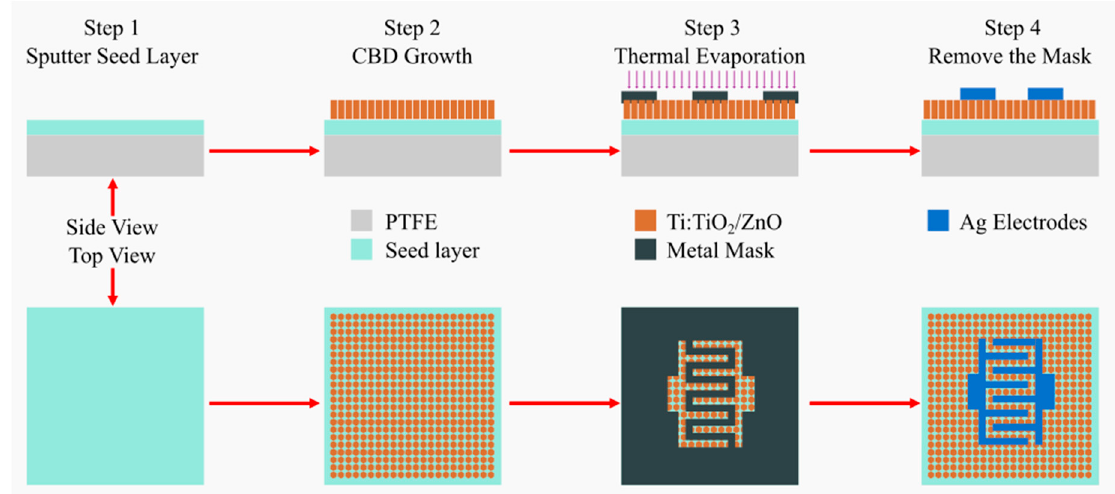
Figure 1. The fabrication steps of the MSM photodetectors.